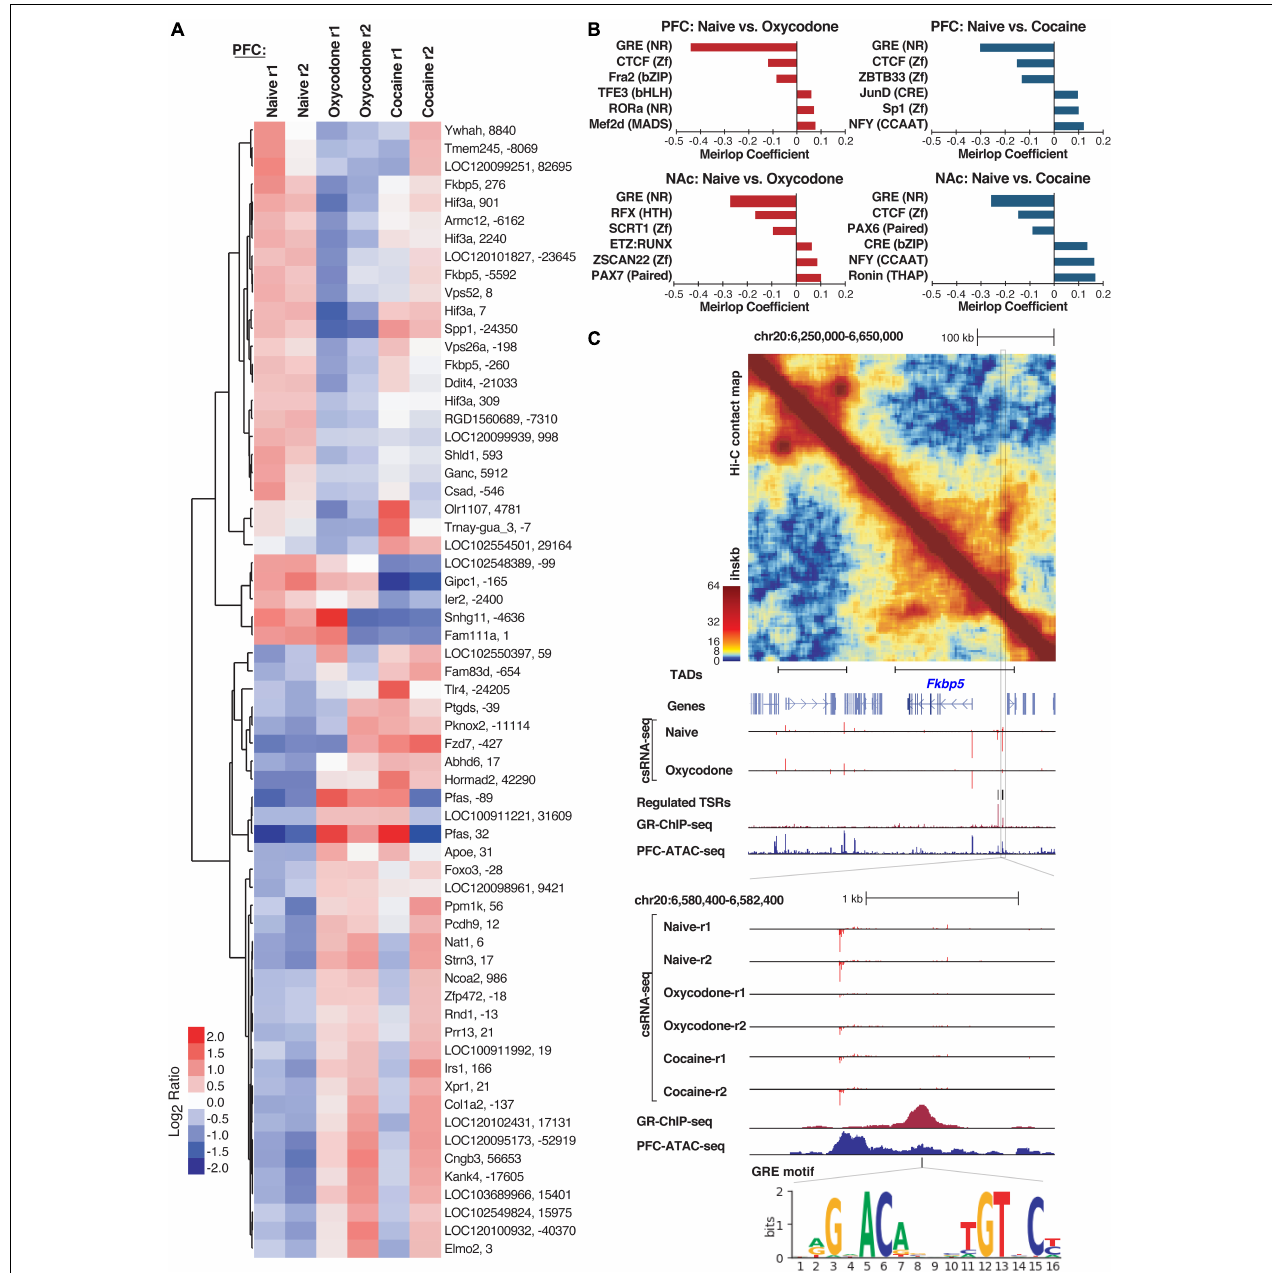
FIGURE 3 | Differentially regulated Transcriptional Start Sites (TSRs) in naïve versus cocaine or oxycodone exposed rat brains. (A) Heatmap of transcription initiation levels from differential TSRs in PFC naïve, oxycodone- and cocaine-exposed rats based on mean-centered log2 ratios; each row shows the closest gene and the TSR position relative to that gene’s annotated TSS. (B) Barplot of significant logistic regression MEIRLOP coefficients for top-ranked motifs associated with regulated TSRs between naïve and oxycodone or cocaine conditions in PFC and NAc . (C) Example of regulation at the Fkbp5 gene locus, including (top to bottom) Hi-C contact matrix with TAD positions, genome browser tracks showing regulated TSRs (csRNA-seq), GR binding (ChIP-seq), chromatin accessibility (ATAC-seq), and GRE motif location. Ihskb = interactions per hundred square kilobases per billion mapped